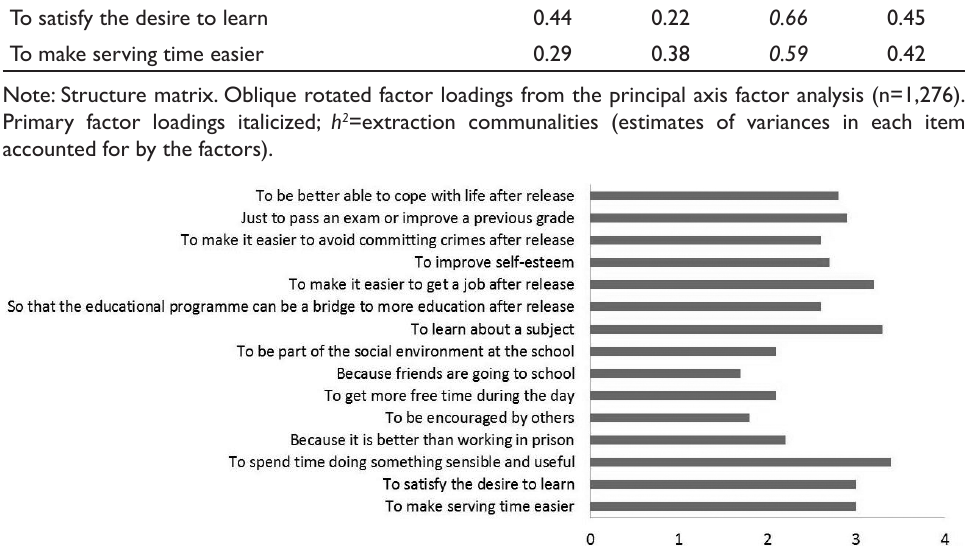
Figure 1: Educational